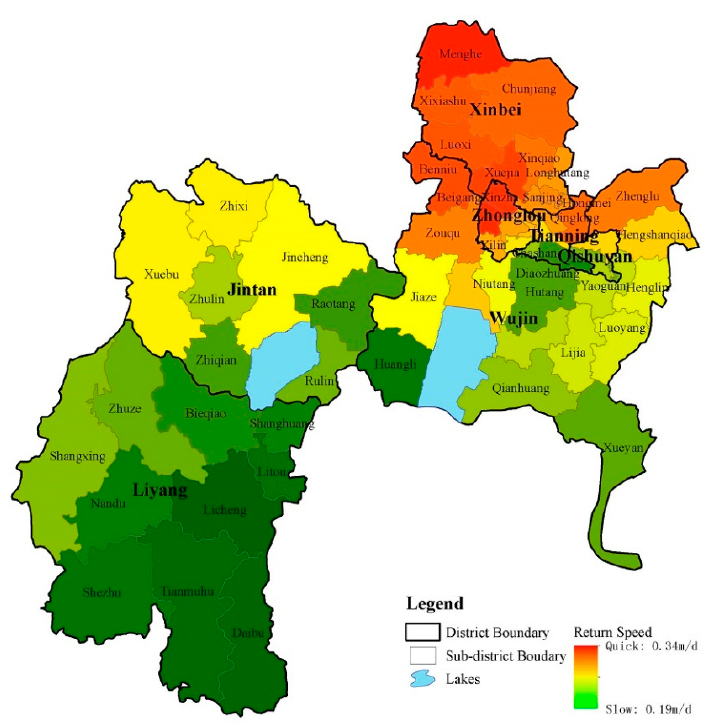
Figure 9. Average Return Speed of Water Level at Sub-district (or town) Level.